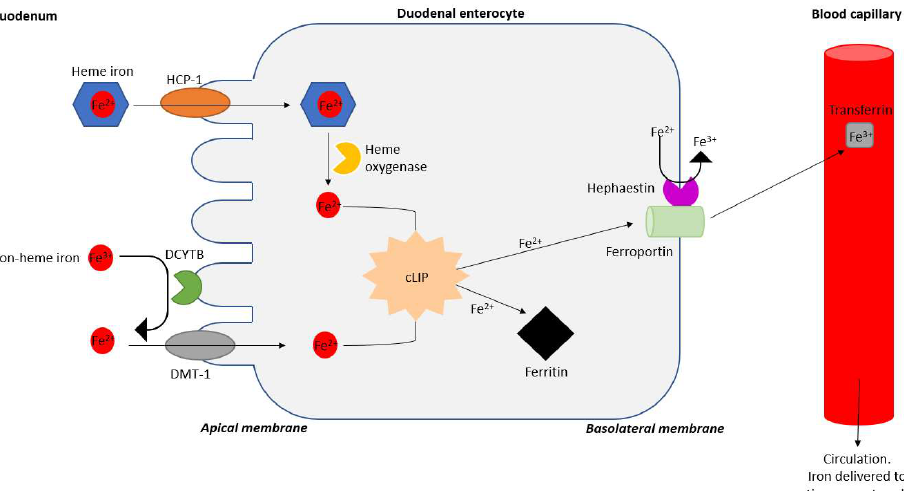
Figure 1. Iron absorption in the body. This can be in the form of heme or non-heme iron. Heme iron is transported into the duodenal enterocyte cytoplasm via HCP-1 (heme carrier protein 1), where the heme iron is then removed from the protoporphyrin X1 ring by heme oxygenase. The Fe 2+ iron then forms part of the cLIP (cytosolic labile iron pool). Non-heme iron must be in the ferrous state before entering the enterocyte lumen. DCYTB (duodenal cytochrome B) reduces Fe 3+ iron to Fe 2+ iron, and then DMT-1 (divalent metal transporter 1) transports Fe 2+ into the enterocyte, where it forms part of the cLIP. Iron in the cLIP can either bind to ferritin for storage or be transported out of the enterocyte via ferroportin and hephaestin, which oxidises the iron to its ferric state and can bind to transferrin in the blood for transport around the body.